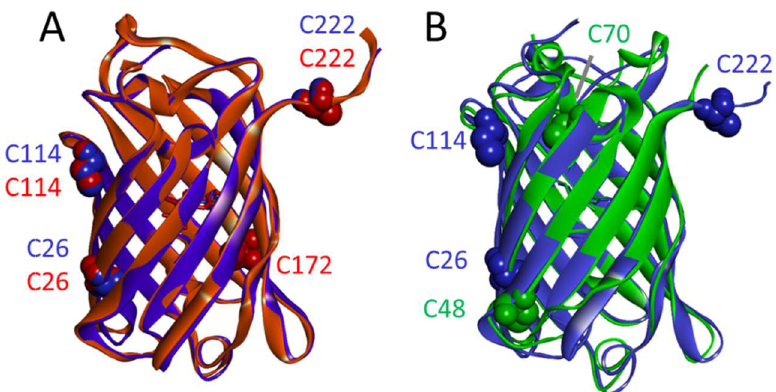
Figure 8. ( A ) Superposition between the structure of mTagBFP2 (blue solid ribbon, PDB 3m24) and mTagRFP-T (red solid ribbon, PDB 5jva). Cys residues are displayed as a space-filling model. ( B ) Superposition between the structure of mTagBFP2 (blue solid ribbon, PDB 3m24) and EGFP (green solid ribbon, PDB 2y0g).